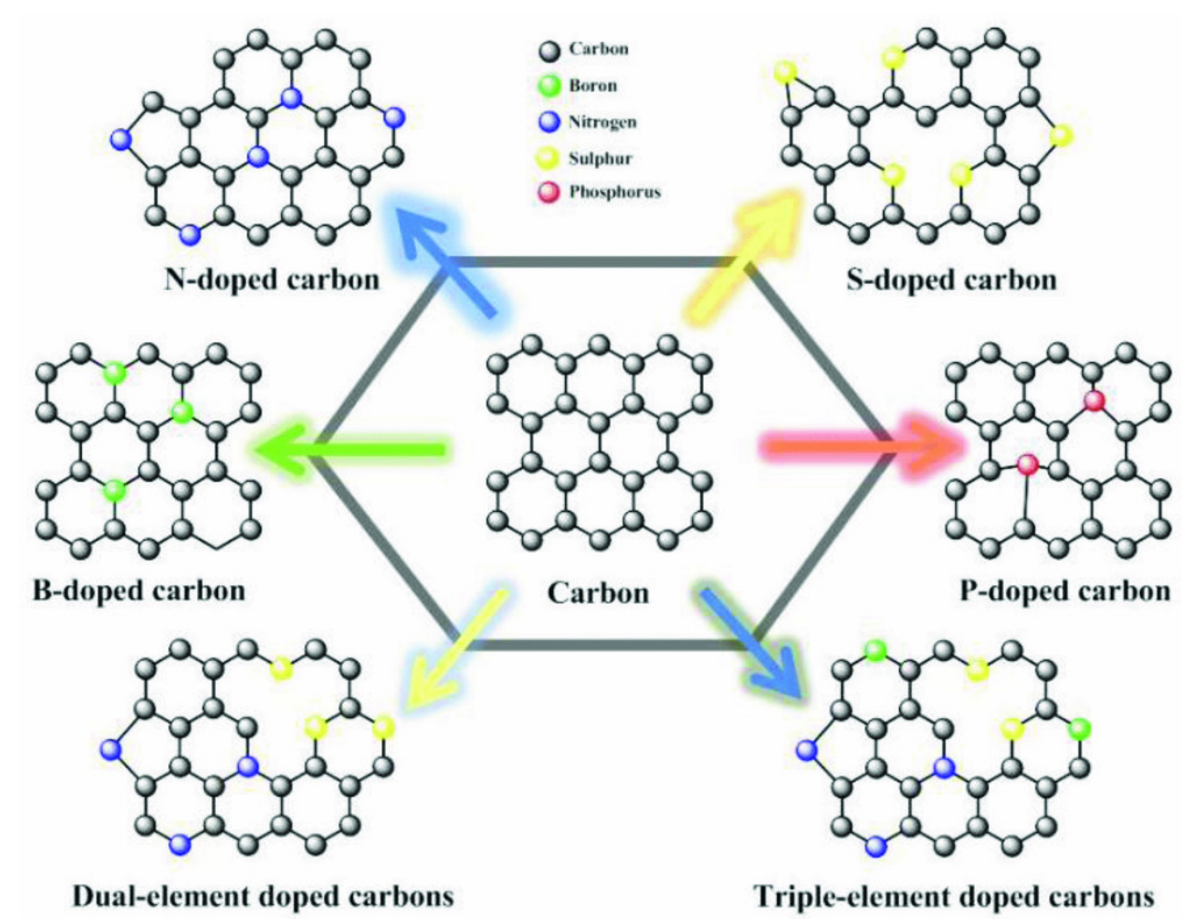
Figure 4. Scheme of various heteroatom-doped carbons. Reproduced from [57] with permission from Wiley.